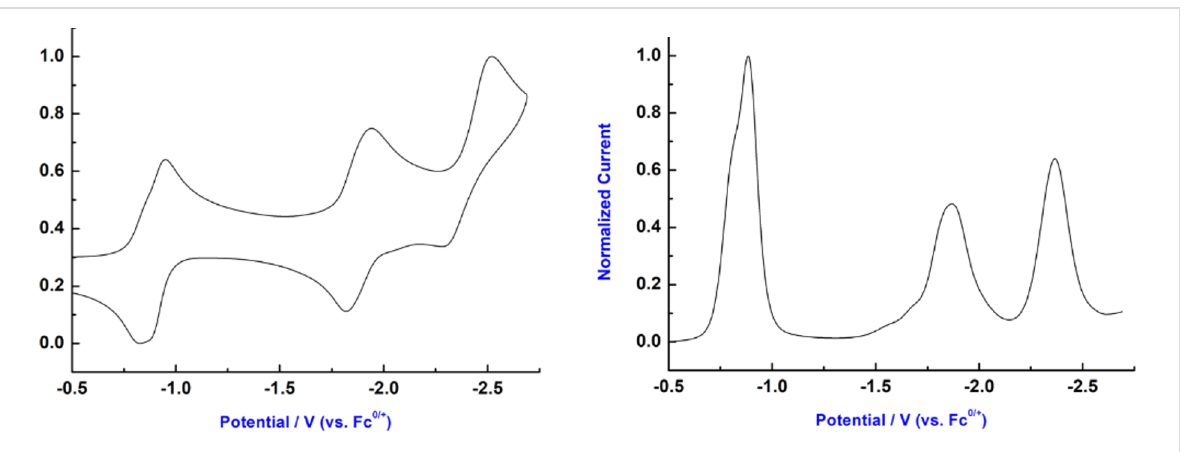
Figure 2: 1 H (top) and 13 C (bottom) NMR spectra of 3a in acetone- d 6 at 25 °C.